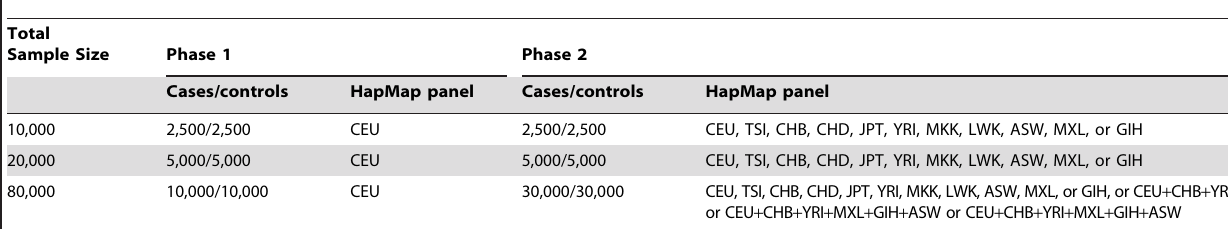
Table 1. Overview of the three main GWAS